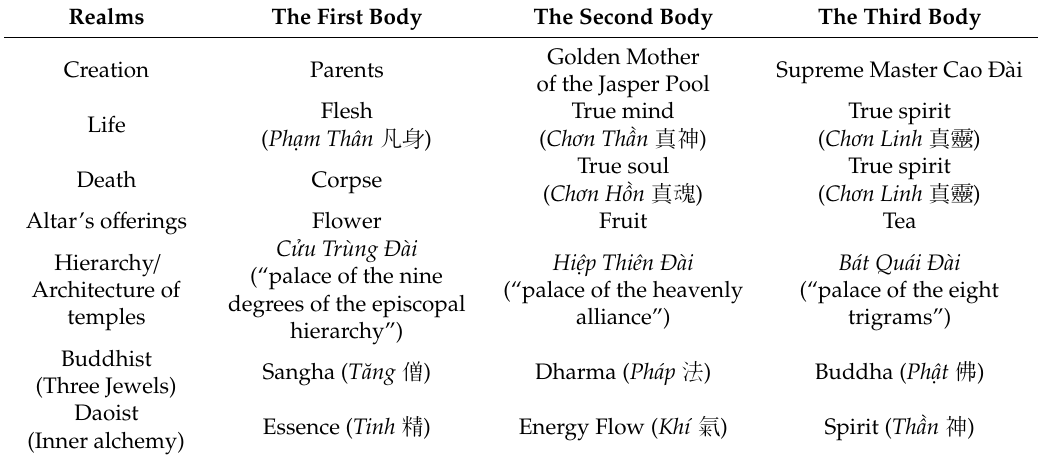
Table 2. The symbolic and structural equivalences of the Three-Body theological conception in Cao Ð à i. Realms The First Body The Second Body The Third Body Golden Mother Creation Parents of the Jasper